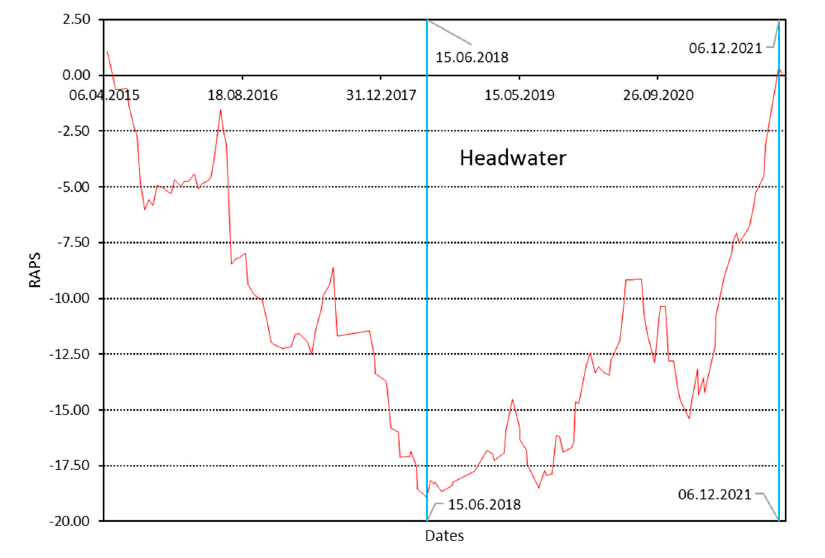
Figure 12. RAPS values for the headwater level of the accumulation lake.